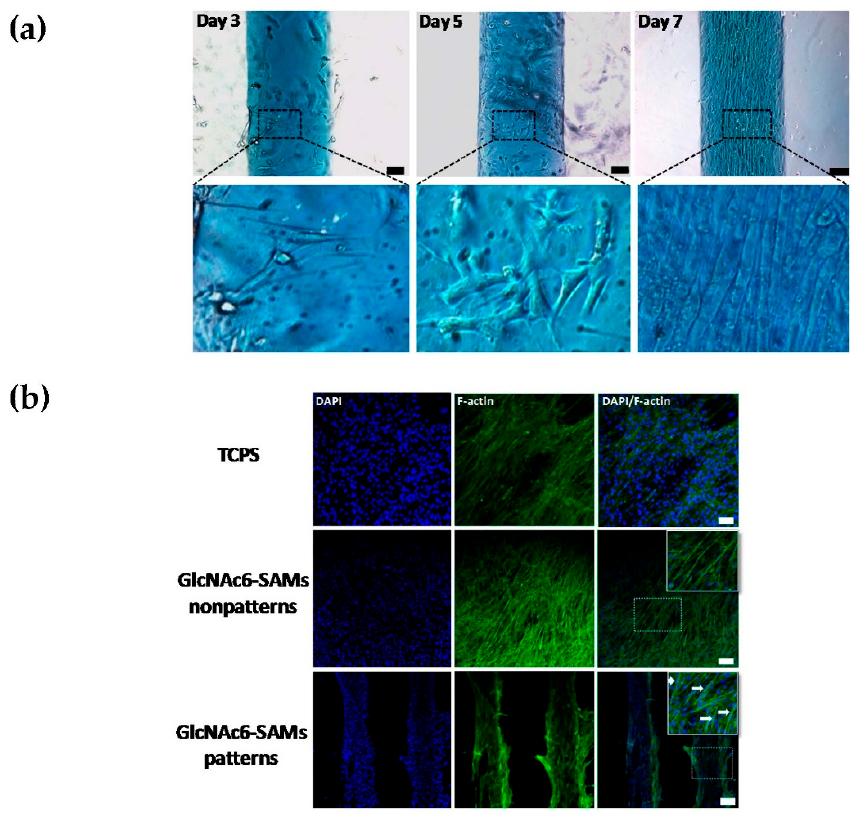
Figure 2. Cont. Figure 2. Cont.